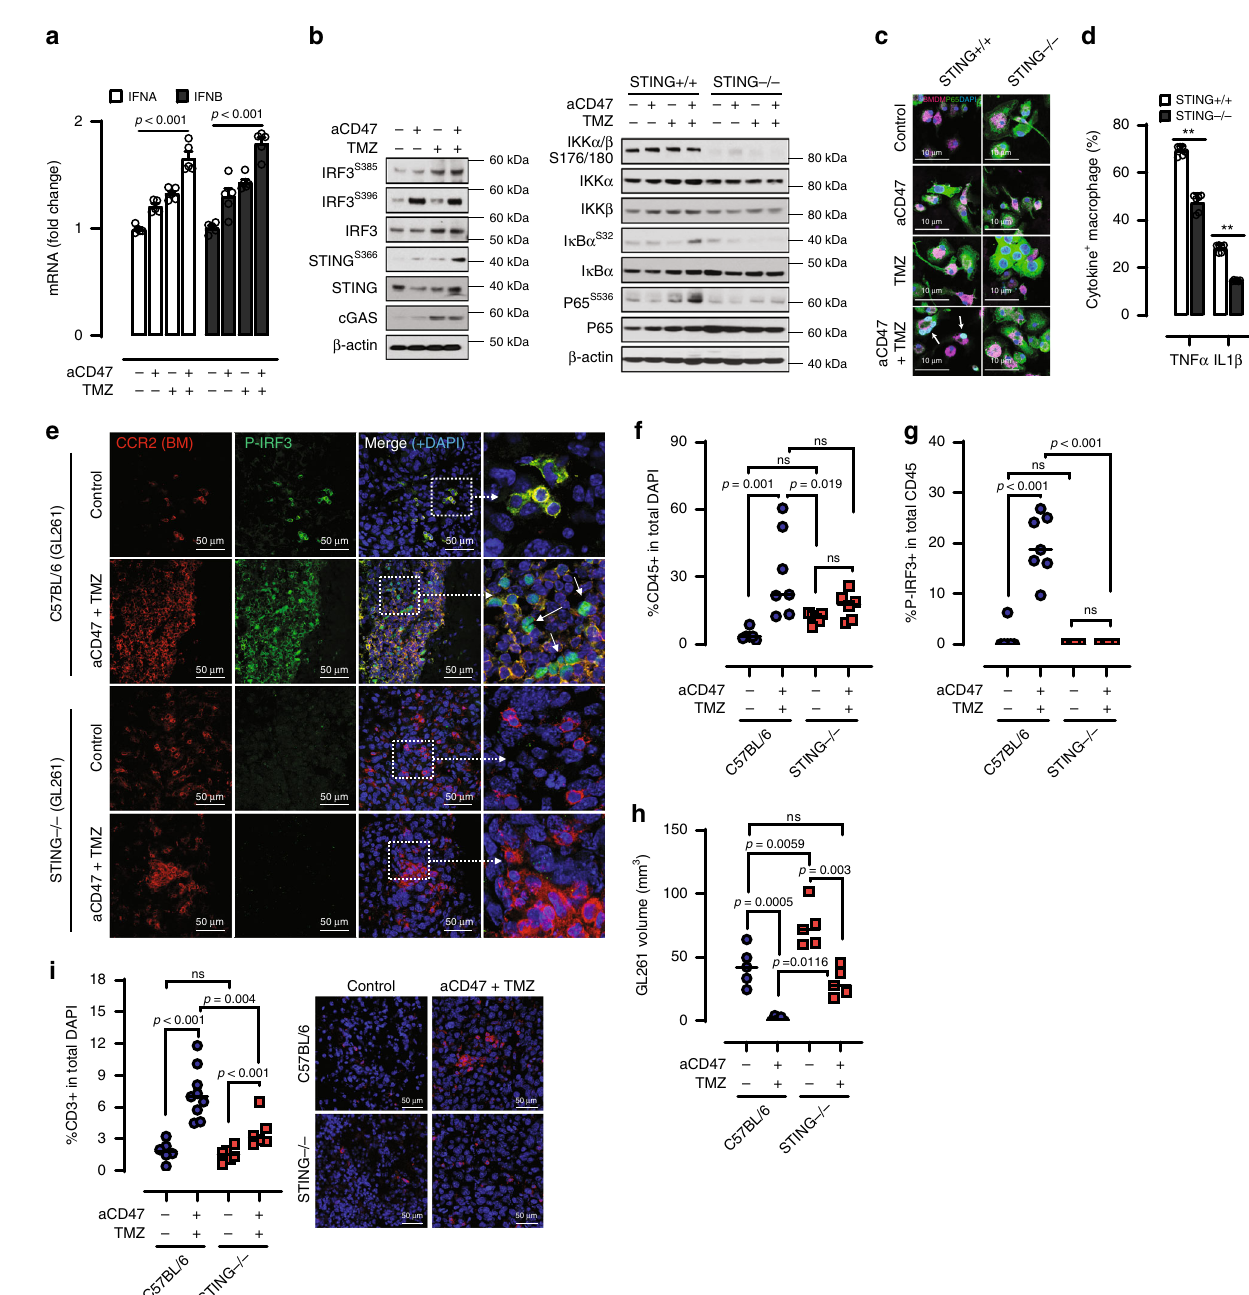
Fig. 4 cGAS-STING pathway is essential for TMZ and anti-CD47 induced immune response. a Combination TMZ and anti-CD47 antibody treatment against murine GBM cells (GL261) increased the production of type I interferons in APCs. IFNA interferon α , IFNB interferon β . n = 5, ** p < 0.01, one-side ANOVA with Bonferroni post hoc correction. b Western blot showing combined TMZ and anti-CD47 antibody treatment resulted in the activation of cGAS-STING cytoplasmic DNA sensing pathways in BM APCs. c Combination TMZ and anti-CD47 antibody treatment promoted p65 expression and nuclear translocation in BM APCs that is dependent on STING. d STING activation is critical to the increased the production of NF- κ B cytokine TNF α and IL1 β in APCs in the setting of combined TMZ and anti-CD47 antibody treatment. n = 6, ** p < 0.01, unpaired Student ’ s t test. e Immuno fl uorescence staining of GL261 tumors implanted in WT and STING KO animals. Nuclear p-IRF3 (Ser 396) in CD45 + cells is indicative of STING signaling activation. f , g Quanti fi cation of CD45 + cell in fi ltration and percentage of p-IRF3 positive CD45 + , C57BL/6, n = 7; knockout, n = 6. Unpaired Student ’ s t test. h GL261 tumor volume in C57BL/6 or STING KO mice at day 20 following control or combination TMZ + aCD47 treatment, n = 5/group. i T-cell in fi ltration in GL261 tumors in C57BL/6 or STING KO mice at day 20 following control or combination TMZ + aCD47 treatment measured by CD3 + cells in total DAPI count per fi eld of view (FOV), C57BL/6, n = 9; knockout, n = 6 unpaired Student ’ s t test. Representative FOV for each group on the right. All error bars = mean ± standard